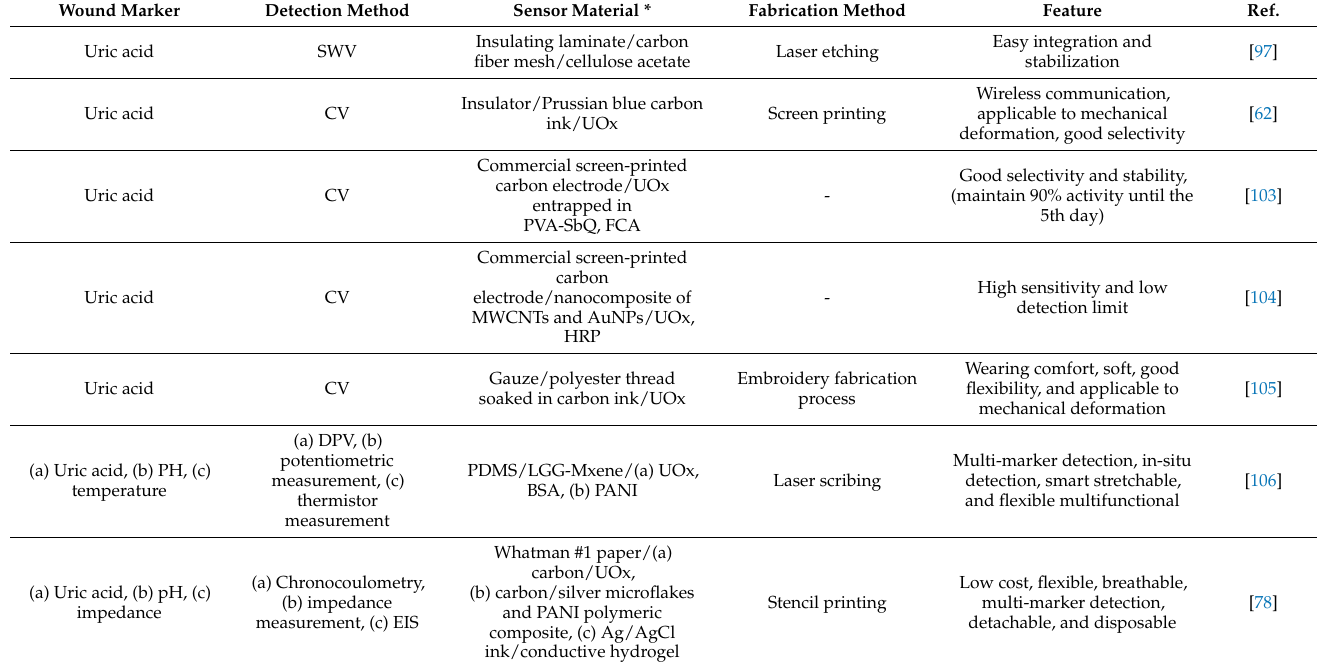
Table 1. The detection methods, sensor materials, fabrication processes, and features of the flexible wearable sensors for wound detection with electrochemical detection principles mentioned in this